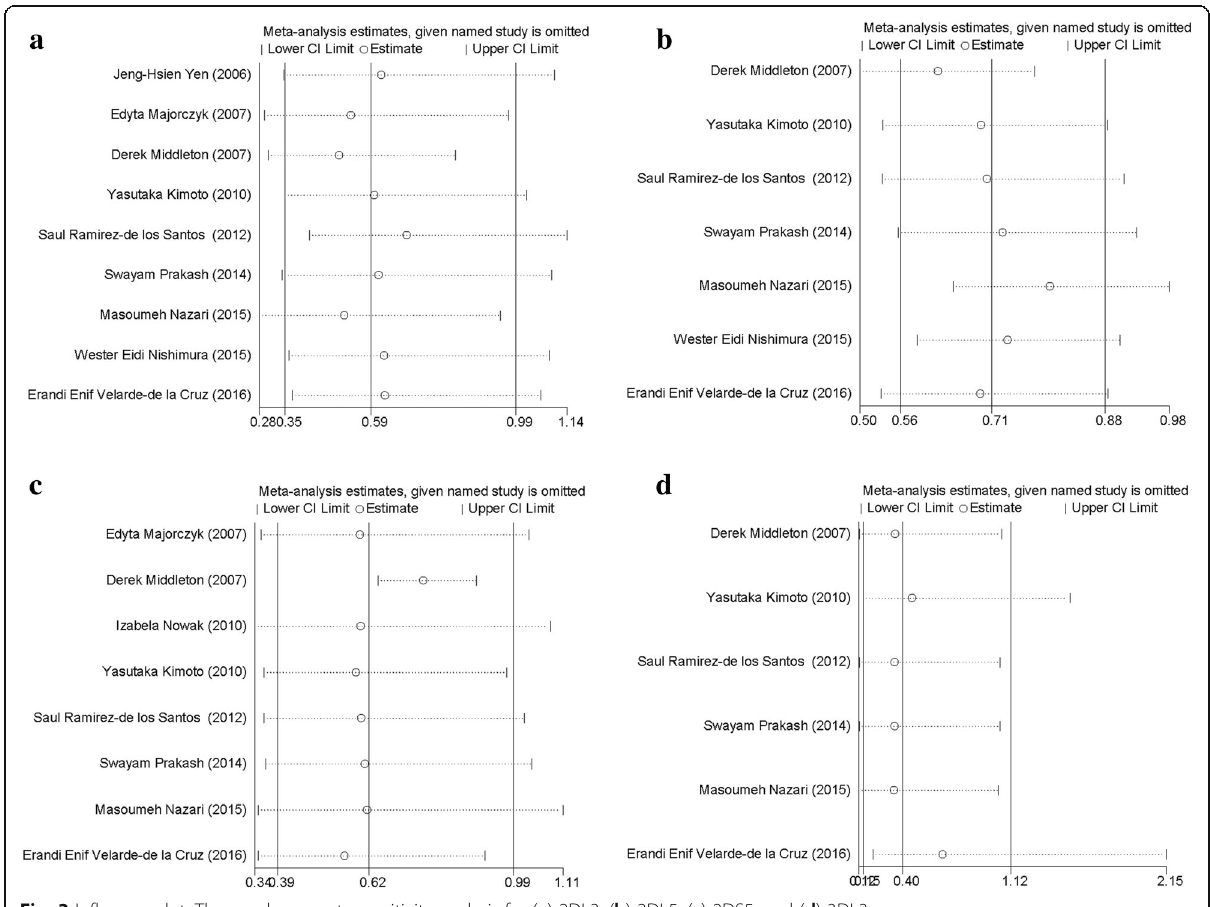
Fig. 3 Influence plot. The graph presents sensitivity analysis for ( a ) 2DL3, ( b ) 2DL5, ( c ) 2DS5, and ( d ) 3DL3